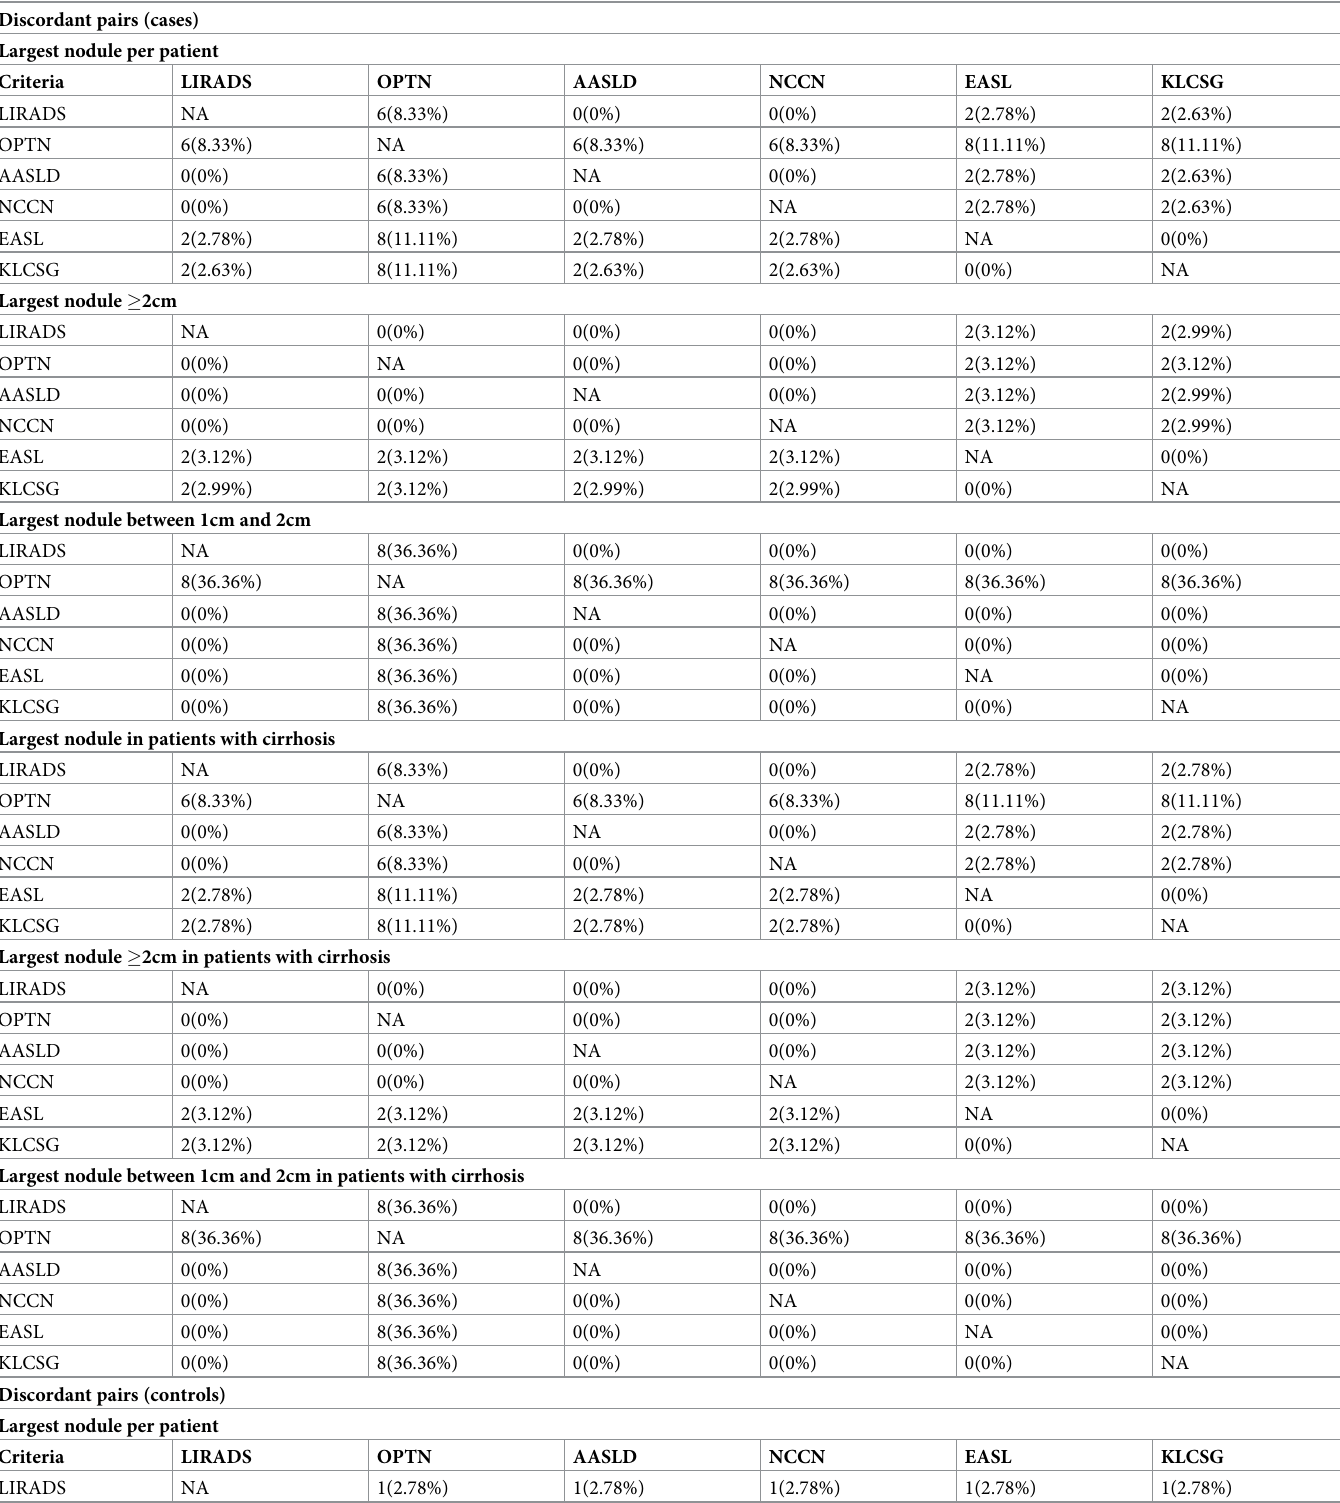
Table 4. Comparison of tests, discordant